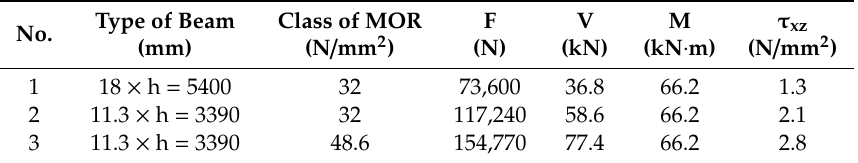
Figure 10. Shear forces diagrams and bending moments diagrams for ( a ) beams consistent with the dimensional requirements of EN 408 and ( b ) experimental beams used in the conducted research. Table 3. Physical quantities for the bend test—No. 1 and 2: theoretical beams, No. 3: a beam with the maximum strength obtained during the